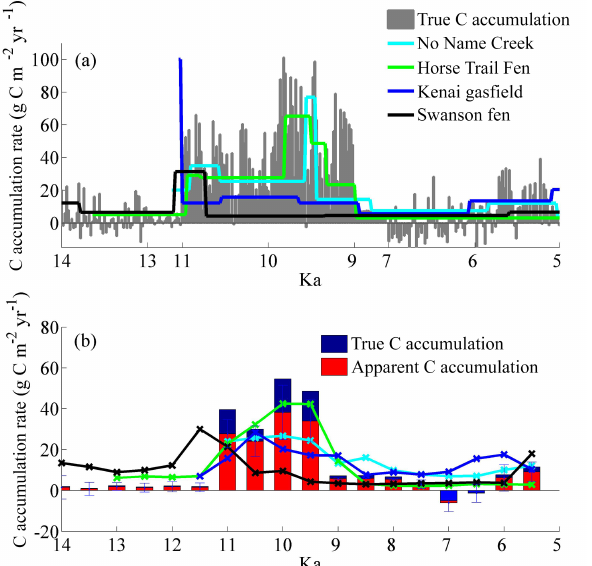
Figure 4. Simulated and observed carbon accumulation rates from 15 to 5ka in 20-year bins (a) and 500-year bins with standard devi- ation (b) for No Name Creek, Horse Trail Fen, Kenai Gasfield, and Swanson Fen. Peat-core data were from Jones and Yu (2010).